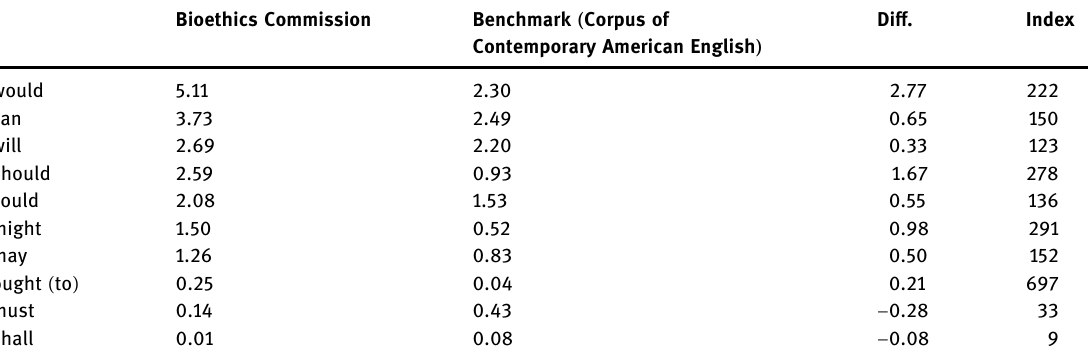
Table 2: Word list extract: frequency of individual modal auxiliary verb use per 1,000 words ( normalised, n = 1,000 ) by commission members, compared to benchmark corpus Bioethics Commission